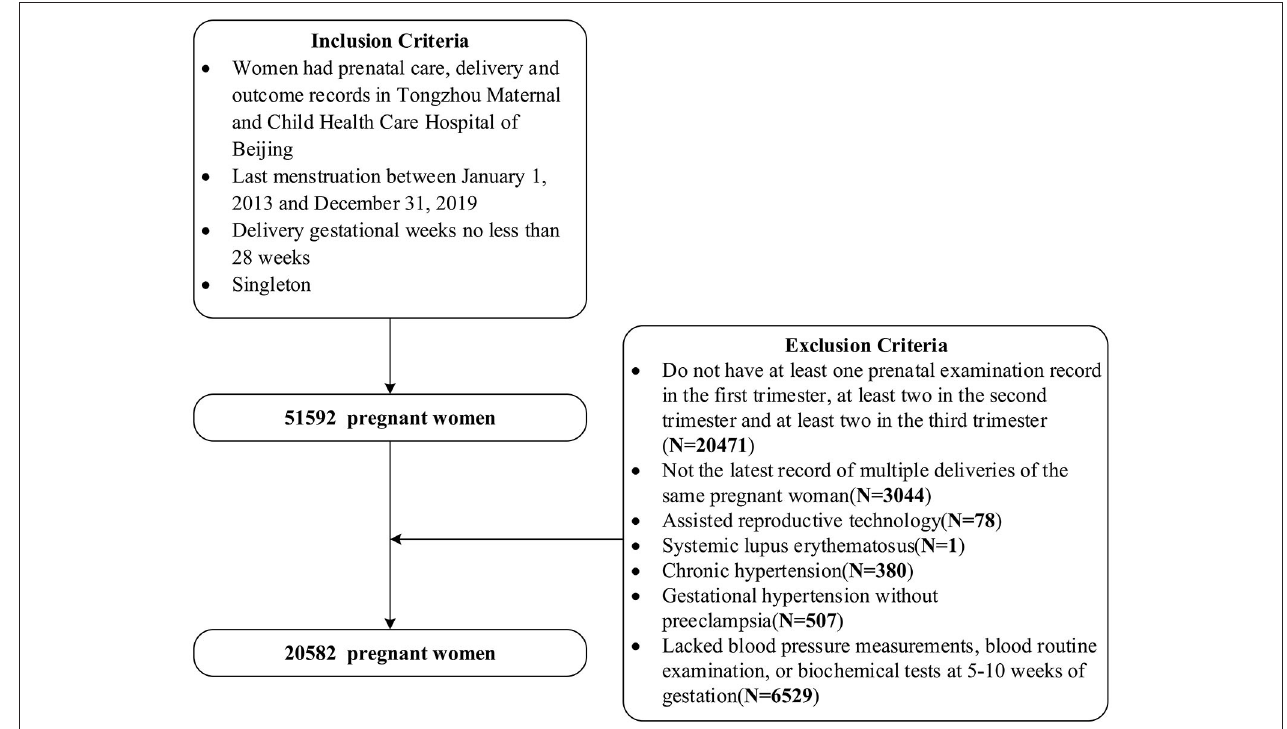
FIGURE 1 | The inclusion and exclusion criteria for the study population.